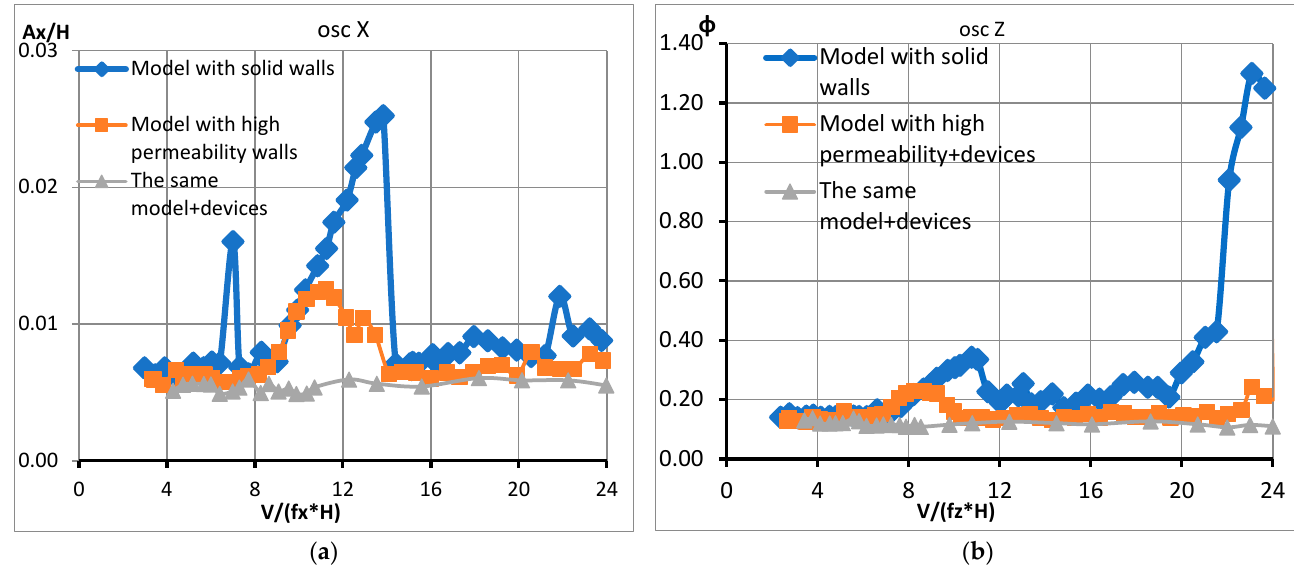
Figure 13. Comparative efficiency of vibration damping devices: Model with wall permeability ( a ), without ( b ).